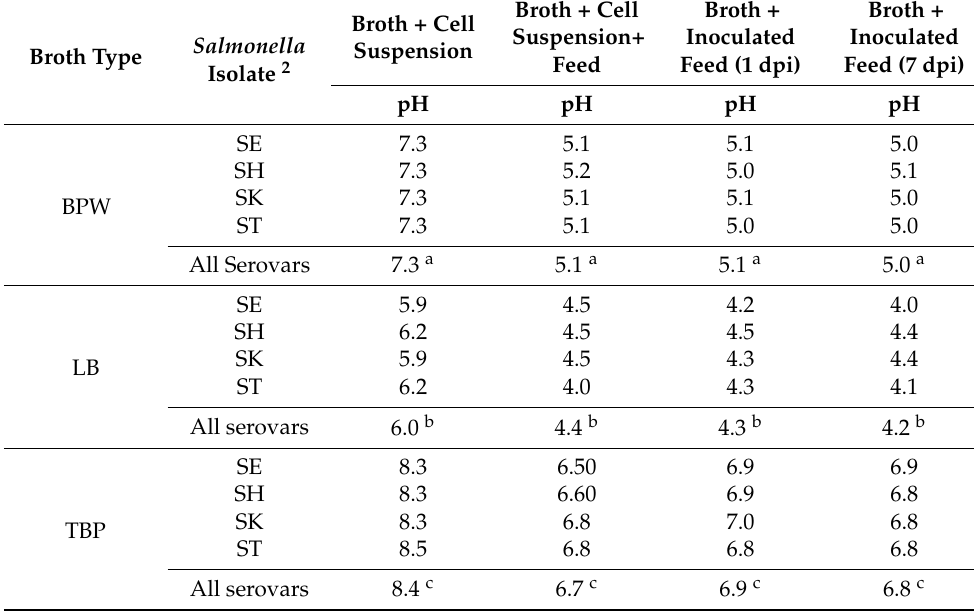
Table 2. pH of pre-enrichment broths after 22 ± 2 h incubation at 37 ◦ C 1